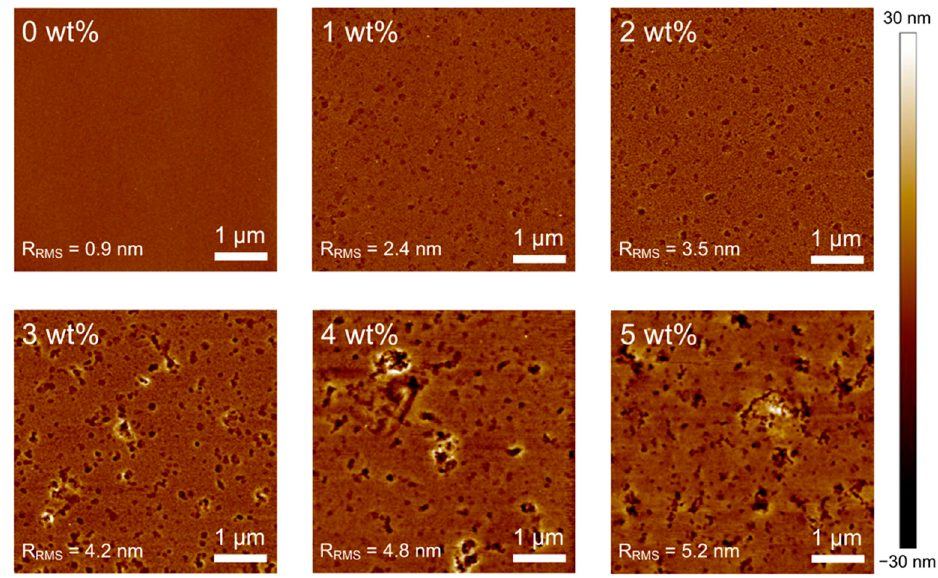
Figure 6. AFM images of PEDOT:PSS films with various concentrations of Brij C10 additive (0, 1, 2, 3, 4, and 5 wt%).